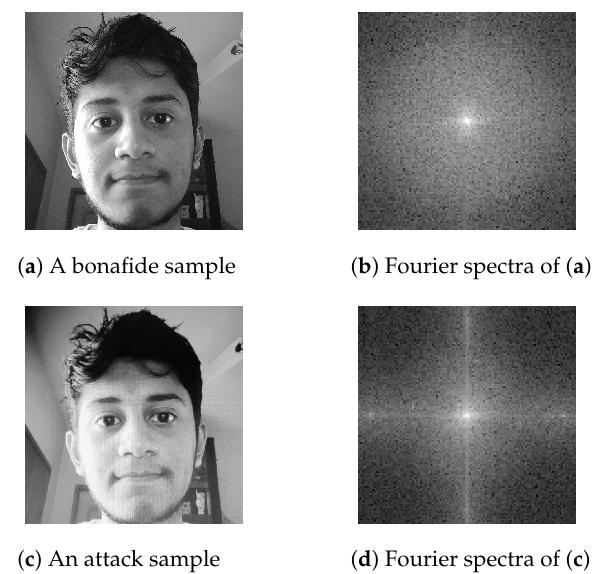
Figure 5. Visualizations of the 2D Fourier spectra for the attack and bonafide classes. Figure ( a ) represents a bonafide sample and ( b ) illustrates its Fourier spectra; Figure ( c ) portrays an attack sample captured through a video replay from a monitor screen, and ( d ) represents its Fourier